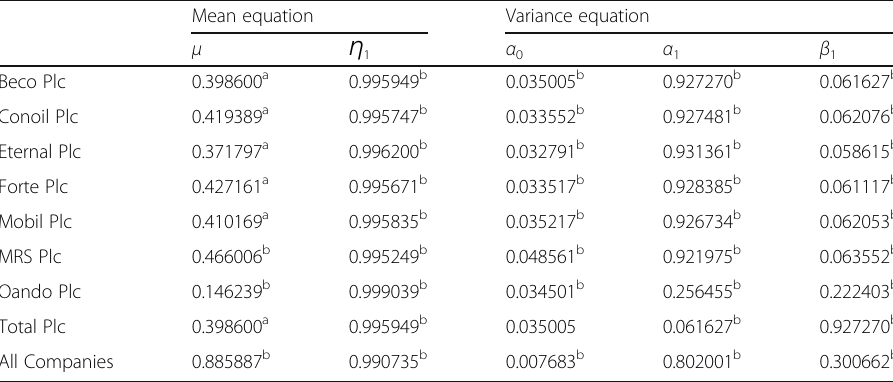
Table 2 GARCH variance estimation